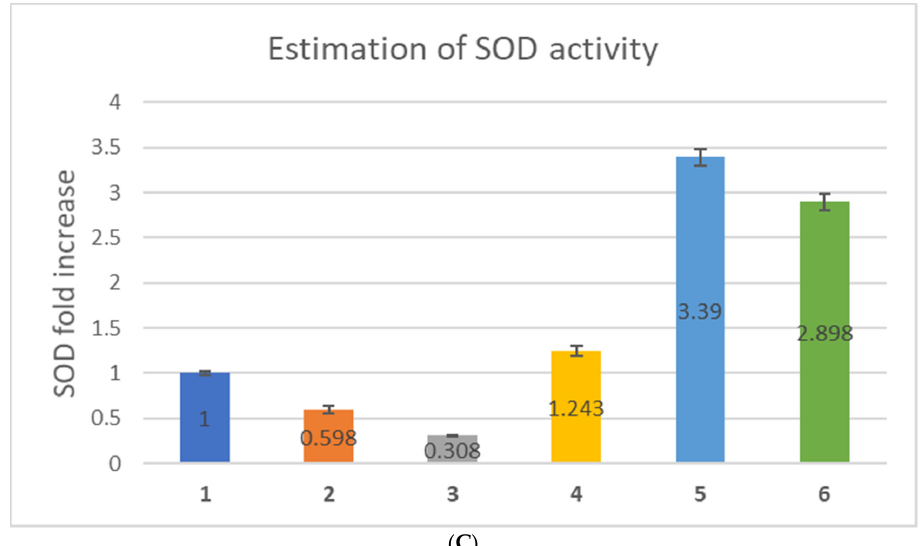
Figure 4. The ( A ) catalase, ( B ) glutathione peroxidase, and ( C ) superoxide dismutase activity of zebrafish embryos without any treatment (control) (1) and after treatment with hydrogen peroxide at 3 mM (oxidative stress) (2). The graph also shows the catalase activity of zebrafish embryos exposed to oxidative stress (hydrogen peroxide, 3 mM) 24 h after treatment with myricetin at low (Myr-L + OS) (3) and high (Myr-H + OS) (4) doses and with liposomal-nanoformulated myricetin at low (n-Myr-L + OS) (5) and high (n-Myr-H + OS) (6) doses.